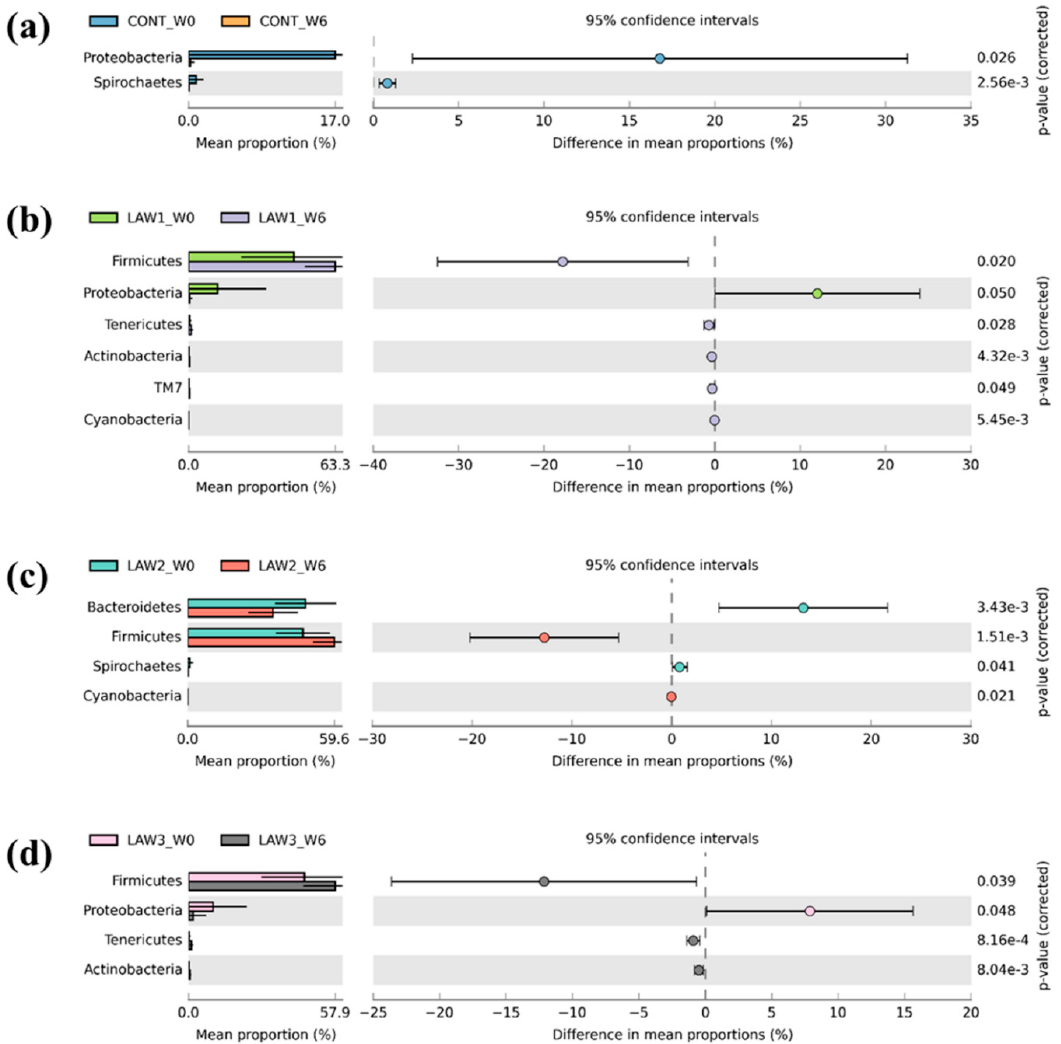
Figure 5. Extended error plots identifying significantly different taxa at the phylum level in pigs orally vaccinated with Lawsonia intracellularis vaccine. Significant differential abundance of phyla between week 0 (W0) and week 6 (W6) for each of the treatment groups ( a ) CONT, ( b ) LAW1, ( c ) LAW2, and ( d ) LAW3 are illustrated. Corrected p -Values are shown at the right. Statistical significance is measured using a two-sided Welch’s t-test and a p < 0.05 is considered significant.